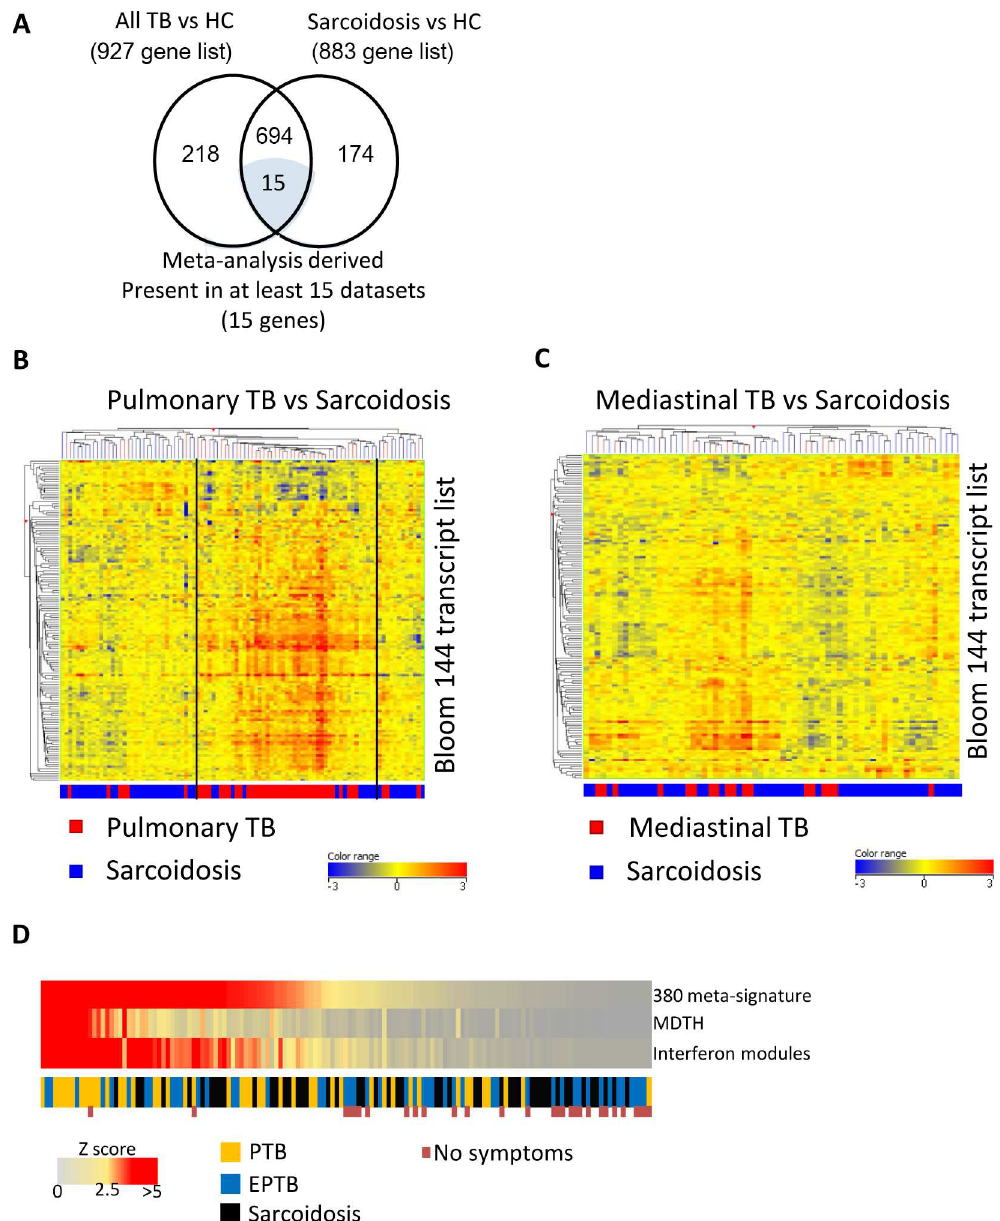
Fig 5. Tuberculosis and sarcoidosis have similar differentially regulated genes. (A) Differentially expressed genes identifiedfrom new dataset for TB and sarcoidosis groups compared to healthy controls (transcripts filtered which were not significantly detected from background in at least 10% of samples, low expressed transcripts filtered (less than 2 fold change from median in 10% of samples), followedby statistical testing (independent t-test with Benjamini Hochbergmultiple testing correction ( q-value < 0.05) between groups of interest). Transcripts were matched to Entrez gene identifiersand duplicatesand non-matched transcripts filtered. Venn diagram showingthe overlapof DEGs between these two diseases and the most significant 15 gene list from the meta-analysis. (B) Heatmap of normalised expression using the Bloom et al 144 transcript list are able to broadlydifferentiate pulmonary TB patients from sarcoidosis patients. Clustering(Pearson’s uncentred (Cosine) with averaged linkage)on transcripts (rows) and individualpatient blood samples (columns). (C) The same 144 transcript list (16) is unableto differentiate between mediastinal TB patients and sarcoidosis patients by clustering (as before) (D) Molecular scores calculated for transcripts from 380 gene meta-signature, MDTH and transcripts representingthe interferon modules (healthy controls acting as control group). Z scores calculated (with healthy controls used as reference group for calculating mean and SD) and then TB patients and sarcoidosis patients ranked accordingto Z score of the 380 gene meta-signature. For all three outcomes